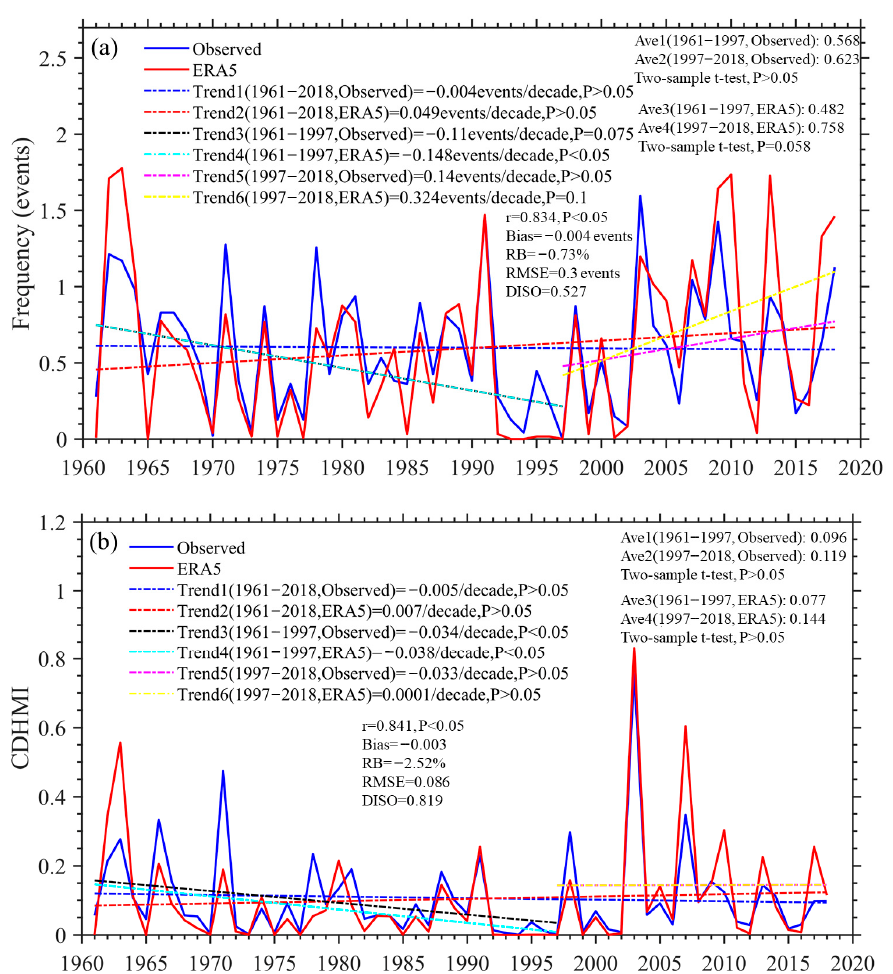
Figure 5. Annual variations of ( a ) CDHWs and ( b ) CDHMI per-year averaged GRB from 1961 to 2018.